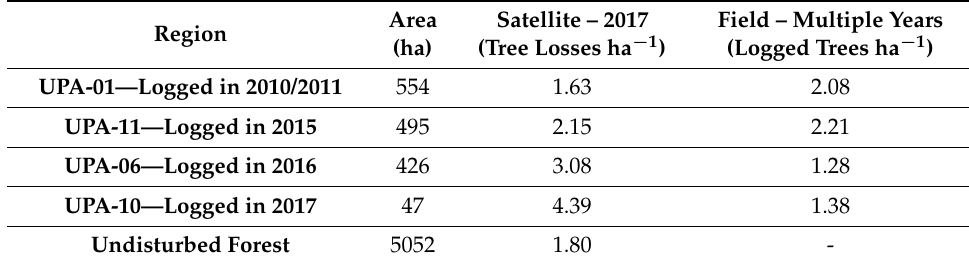
Table 3. Frequency of satellite-based tree loss events and field logged trees per hectare for the UPAs and undisturbed forests.